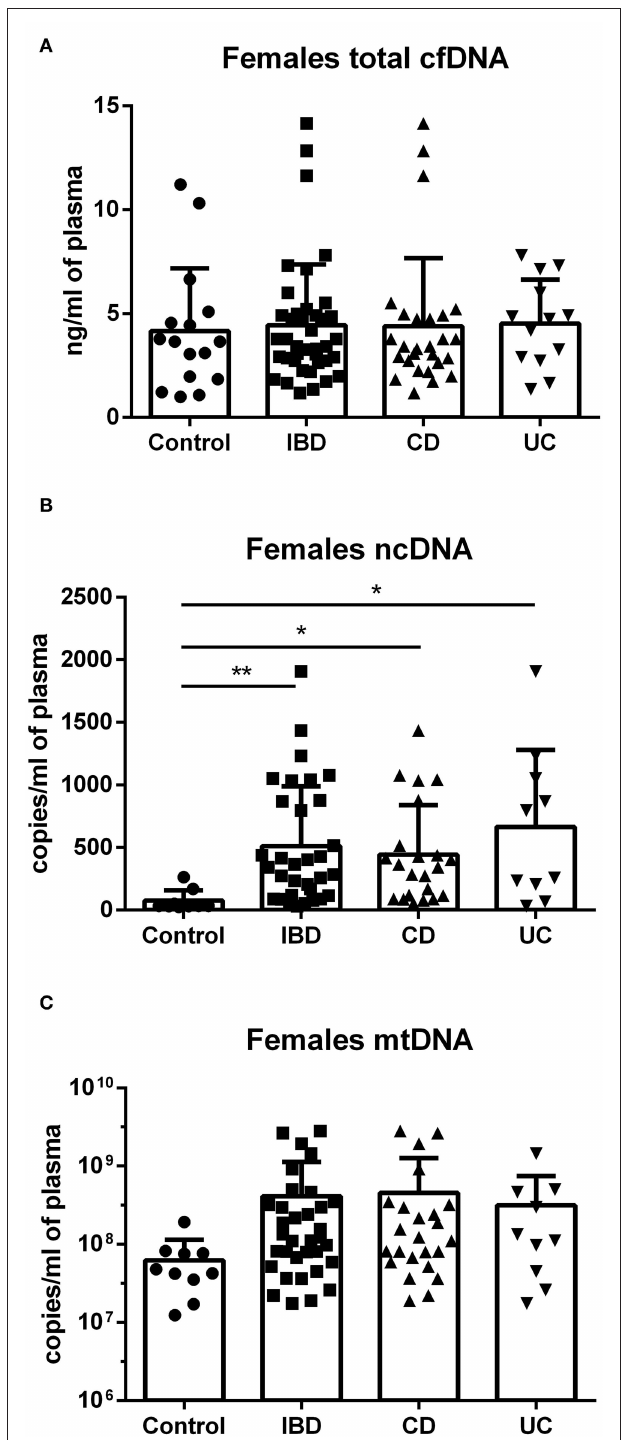
FIGURE 3 | Total cfDNA, ncDNA and mtDNA in females. No difference was found between groups in total cfDNA (A) . Higher amount of ncDNA was found in female IBD patients ( p = 0.0098), including both CD ( p = 0.0108) and UC ( p = 0.0110) compared to healthy controls (B) . Similar trend is seen in mtDNA, although the differences were not significant (C) . * P < 0.05, ** P < 0.01.